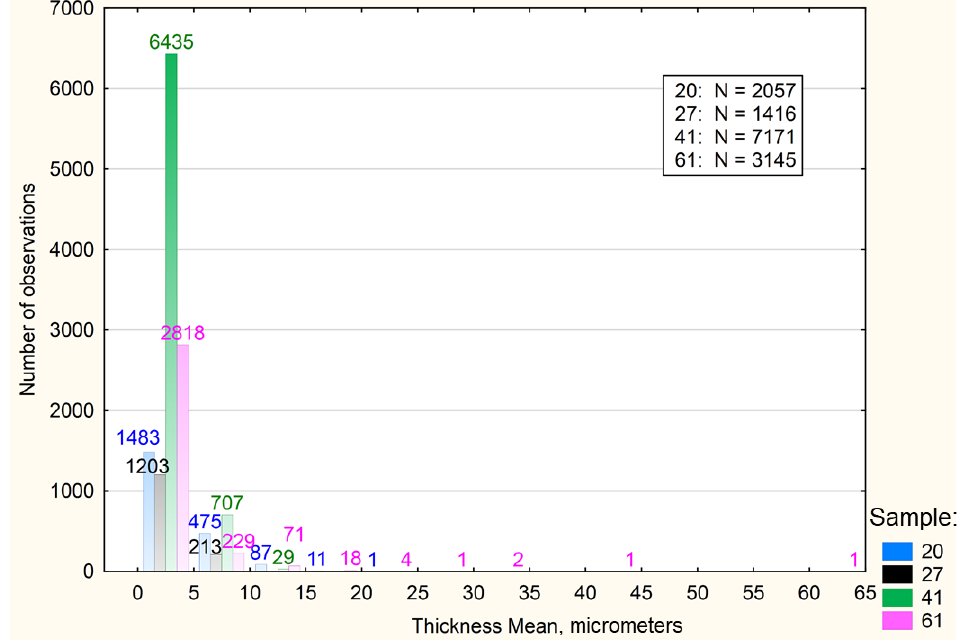
Figure 7. Pore size distribution reflected by thickness mean.